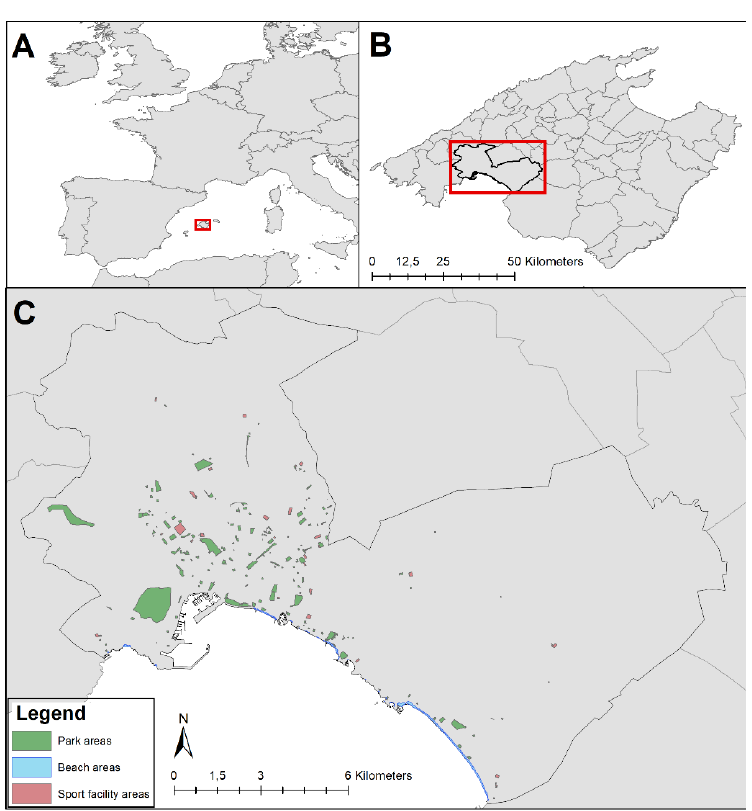
Figure 1. Study area of city of Palma de Mallorca, with location of the Public Open Spaces: parks (green), beach (blue), sport facility (red).